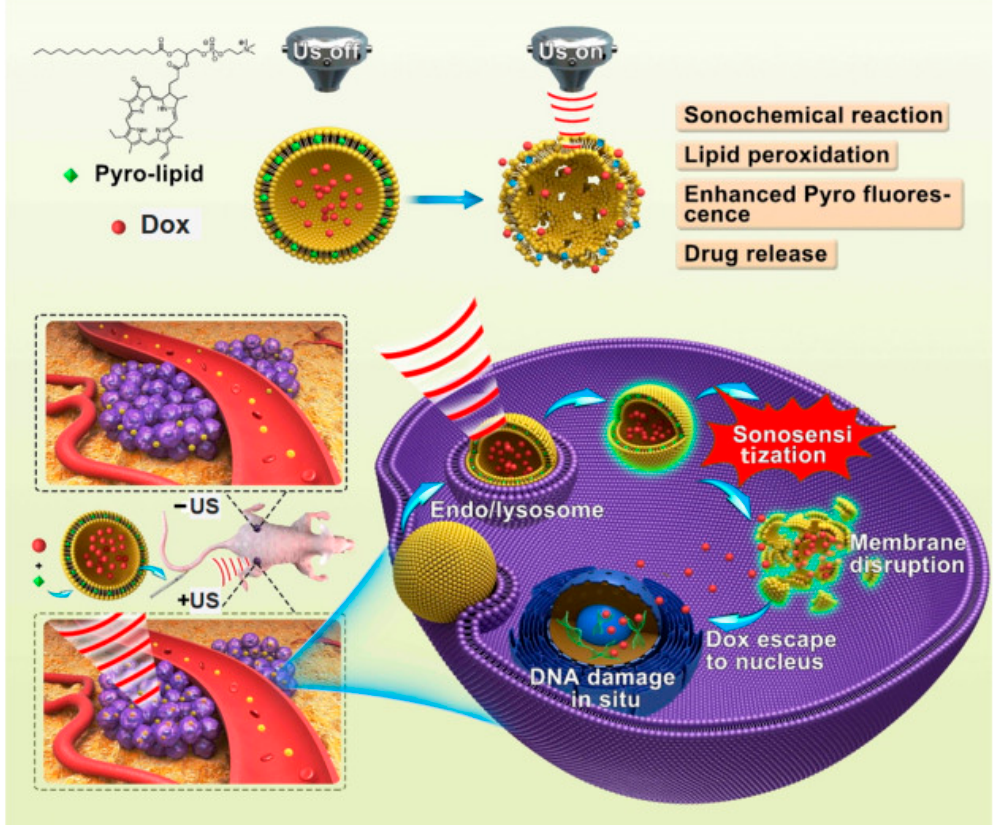
Figure 8. Representation of sonoactivatable, Dox-loaded porphyrin-phospholipid-liposome